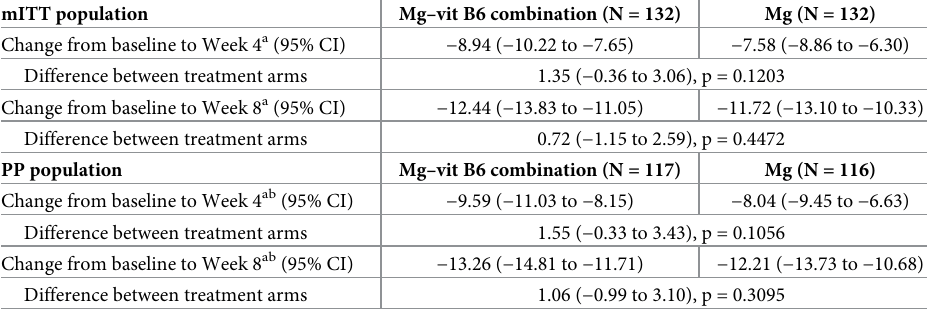
Table 3. Change in DASS-42 stress subscale score from baseline to Week 4 and to Week 8. mITT population Mg–vit B6 combination (N = 132) Mg (N = 132) Change from baseline to Week 4 a (95% CI) 1.35 ( − 0.36 to 3.06), p = 0.1203 Change from baseline to Week 8 a (95% CI) Difference between treatment arms 0.72 ( − 1.15 to 2.59), p = 0.4472 PP population Mg–vit B6 combination (N = 117) Mg (N = 116) Change from baseline to Week 4 ab (95% CI) − 9.59 ( − 11.03 to − 8.15) Difference between treatment arms 1.55 ( − 0.33 to 3.43), p = 0.1056 Change from baseline to Week 8 ab (95% CI) Difference between treatment arms 1.06 ( − 0.99 to 3.10), p =